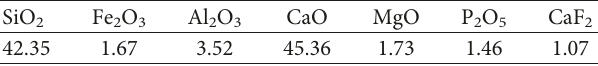
Table 2: Chemical compositions of phosphorite slag (%).